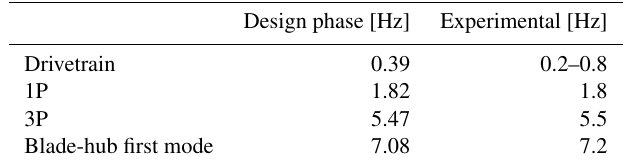
Table 3. Characteristic frequencies of the